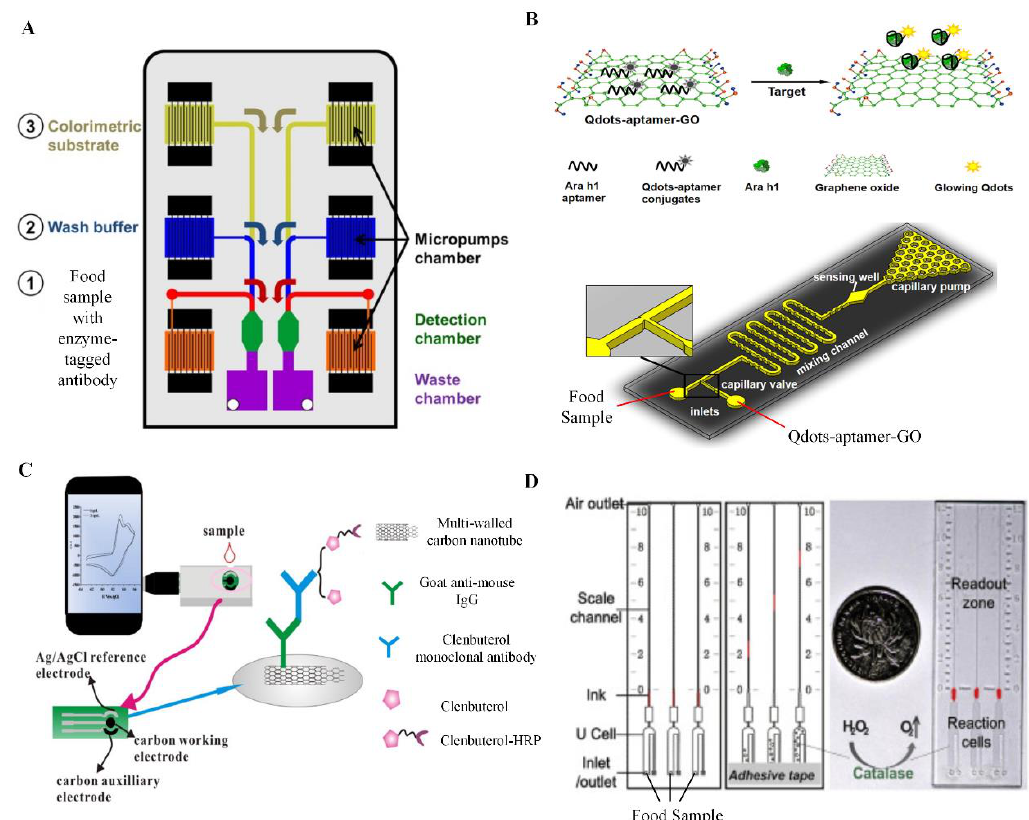
Figure 2. Emerging chip-based point-of-care (POC) devices for food safety analysis. ( A ) An automated chip-based enzyme-linked immunosorbent assay (ELISA) was developed for colorimetric detection of tetrabromodiphenyl ether in water. Adapted with permission from [66] © AIP Publishing (2014). ( B ) A chip-based fluorescent device coupled with quantum dots (Qdots), aptamer and graphene oxide (GO) was developed for sensitive detection of food allergen Ara h1 in biscuit. Adapted with permission from [68] © Elsevier (2016). ( C ) A chip-based electrochemical device functionalized with antibody immobilized multi-walled carbon nanotube was developed for rapid detection of clenbuterol in water. Adapted with permission from [77] © Elsevier (2016). ( D ) A volumetric chip was introduced for the detection of bovine catalase in milk without the requirement of any external detector. Adapted with permission from [83] © Elsevier (2016). Ag: silver; AgCl: silver chloride; IgG: immunoglobulin G; HRP: horseradish peroxidase; H 2 O 2 : hydrogen peroxide; O 2 : oxygen.